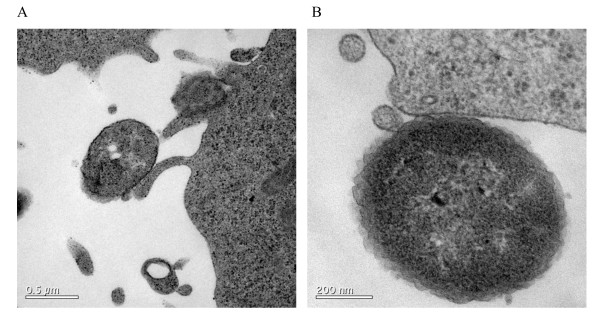
Transmission electron micrographs showing the adherence of E. sakazakii strain ES5 to Hep-2 cells. Bacterial cells appear in close contact with the mammalian cell membrane.